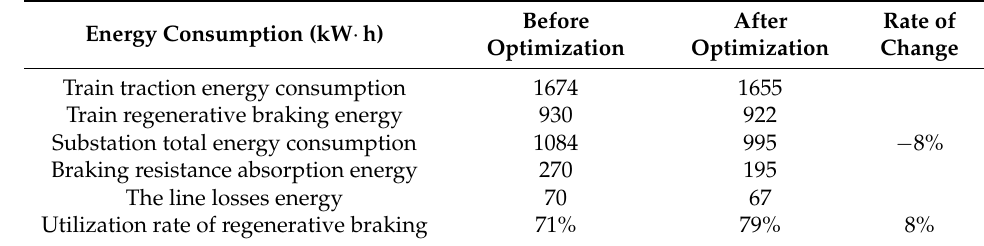
Table 6. Energy consumption after dwell time